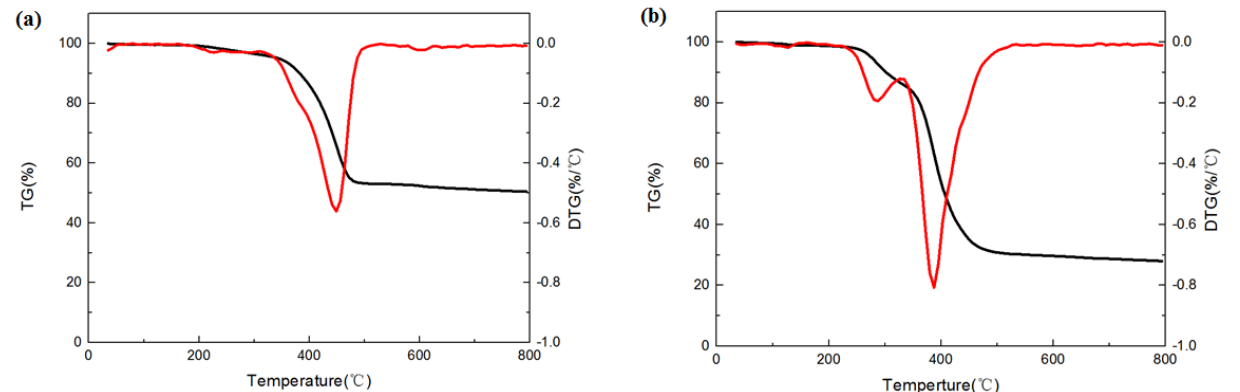
Figure 5. TGA (black lines) and DTGA (red lines) curves of WRP ( a ), HRP ( b ).